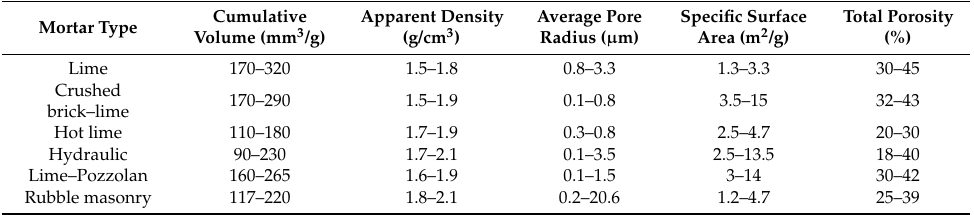
Table 8. Range of acceptability limits for different types of restoration mortars through mercury intrusion porosimetry results (MIP)—microstructural compatibility